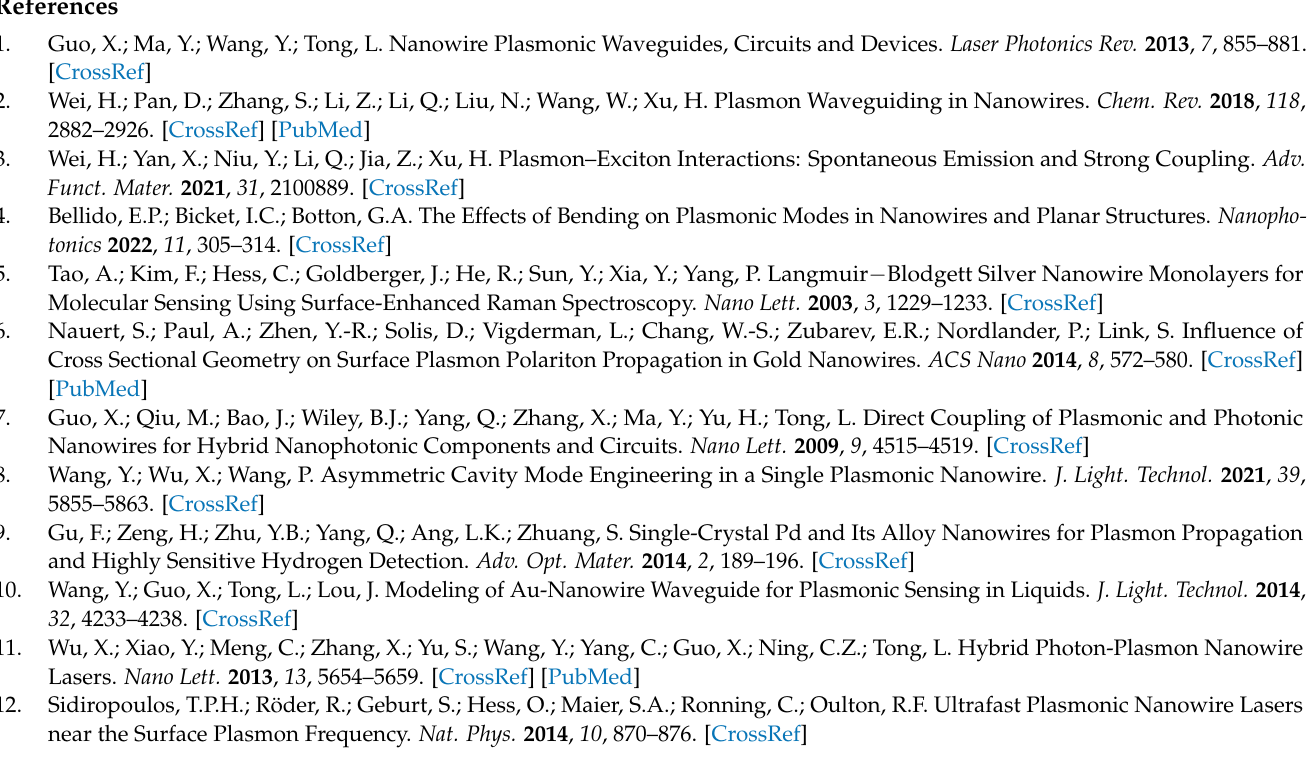
Figure S2: Mappings of waveguiding properties of MNWs with different configurations.; Figure S3: Dependences of effective indices and errors on normalized diameters. References [48–51] are cited in the supplementary